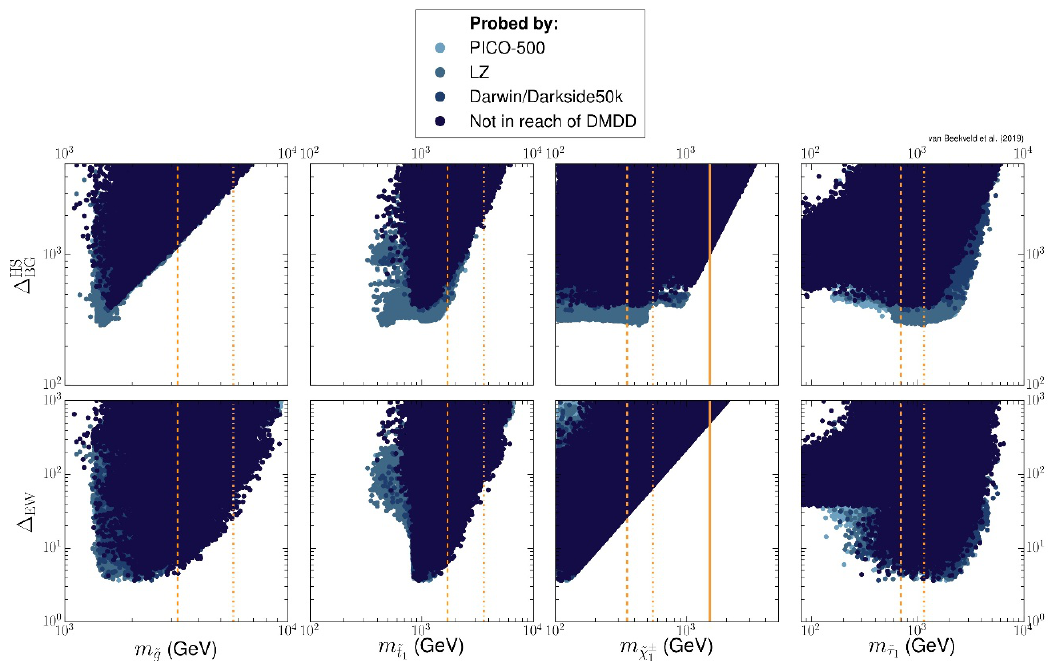
Figure 9 . The values for (cid:1) HS (top) and (cid:1) EW (bottom) against (from left to right) m ~ g , m ~ BG and m ~ (cid:28) for the allowed NUHGM spectra. The masses are given in units of GeV. The color code 1 and plotting order is the same as in (cid:12)gure 1. The dashed, dash-dotted and solid orange line